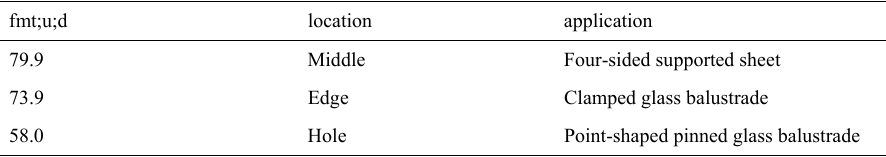
Table 1: Bending strength of hardened glass depending on location of cross